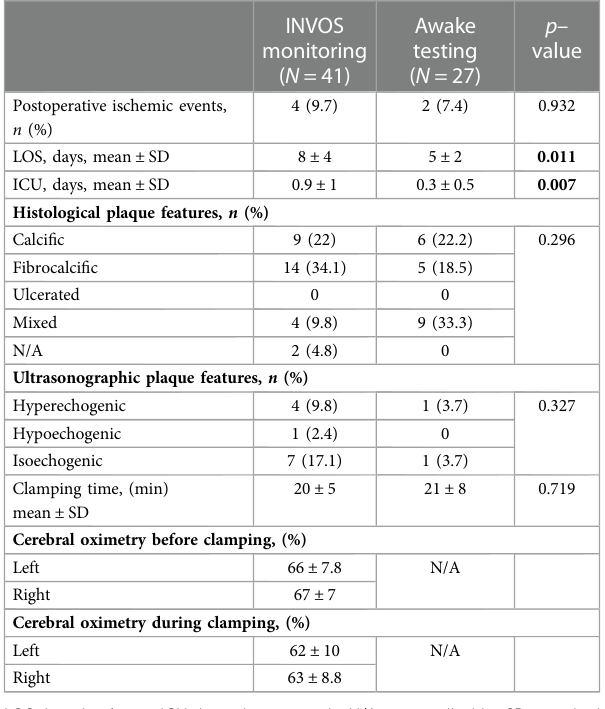
TABLE 2 Postoperative outcomes in INVOS monitoring versus awake testing